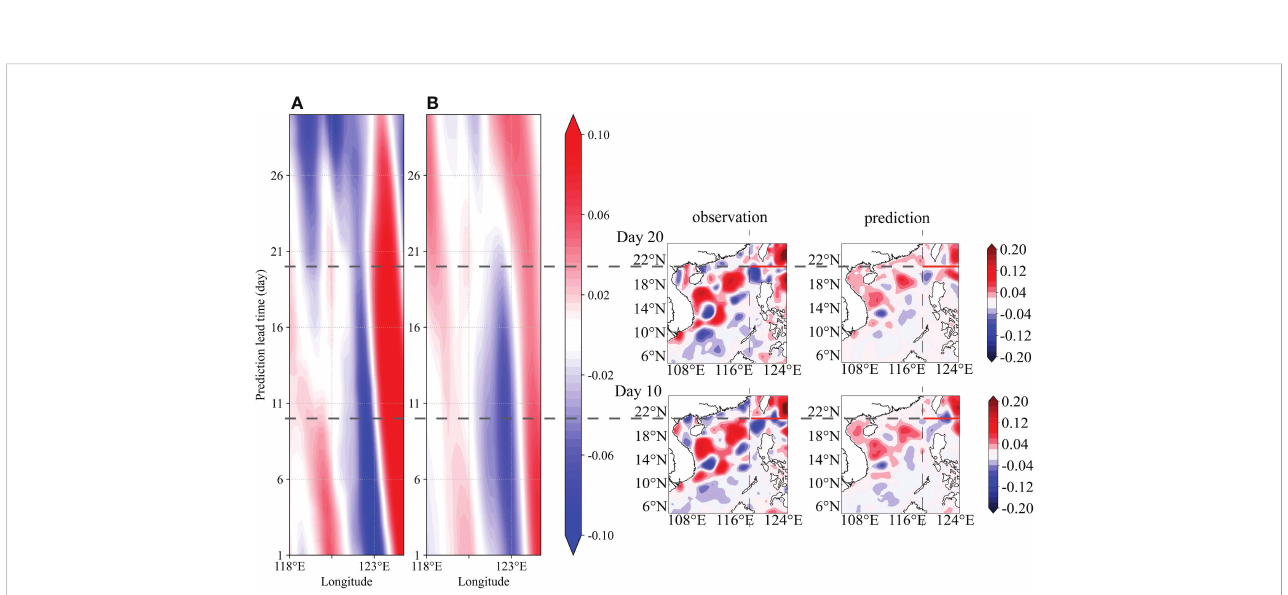
FIGURE 9 Longitude-time maps at the 21.5°N section. (A) observation, (B) prediction. The red solid line is the longitude range (118°E-124.75°E) of the